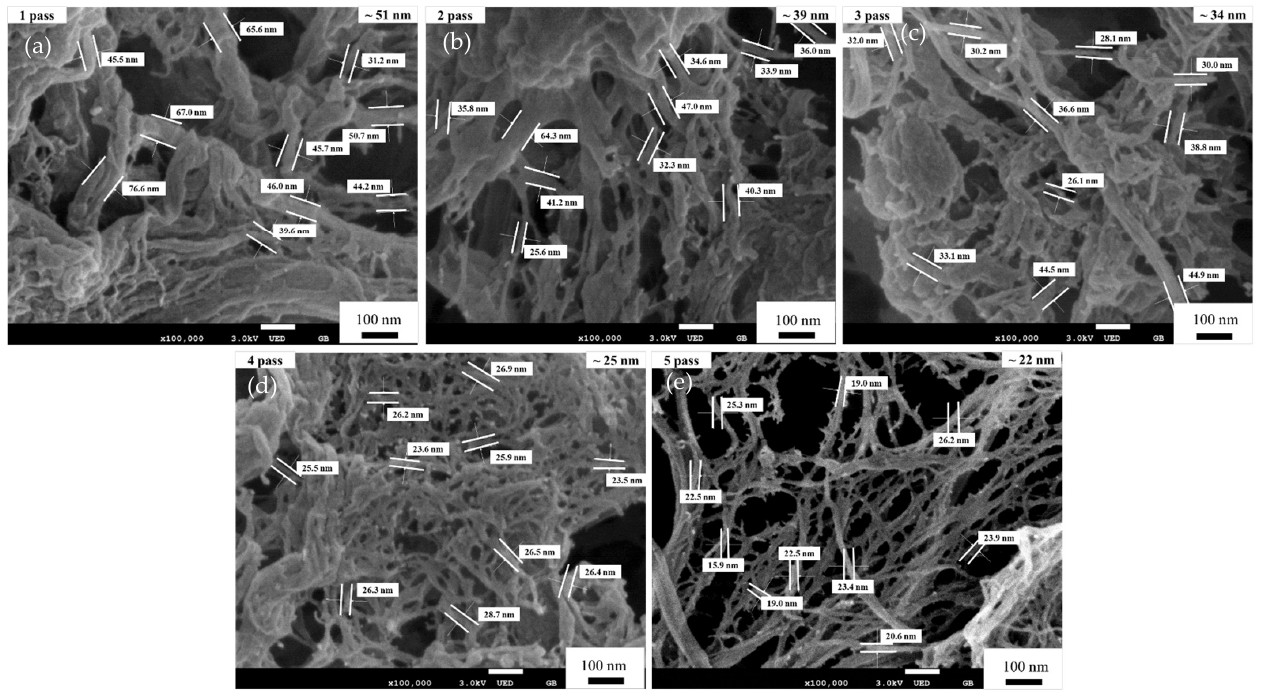
Figure 10. FE-SEM micrographs (×100,000) of CNFs after disc grinding without a PBM for ( a ) one pass, ( b ) two passes, ( c ) three passes, ( d ) four passes, and ( e ) five passes.